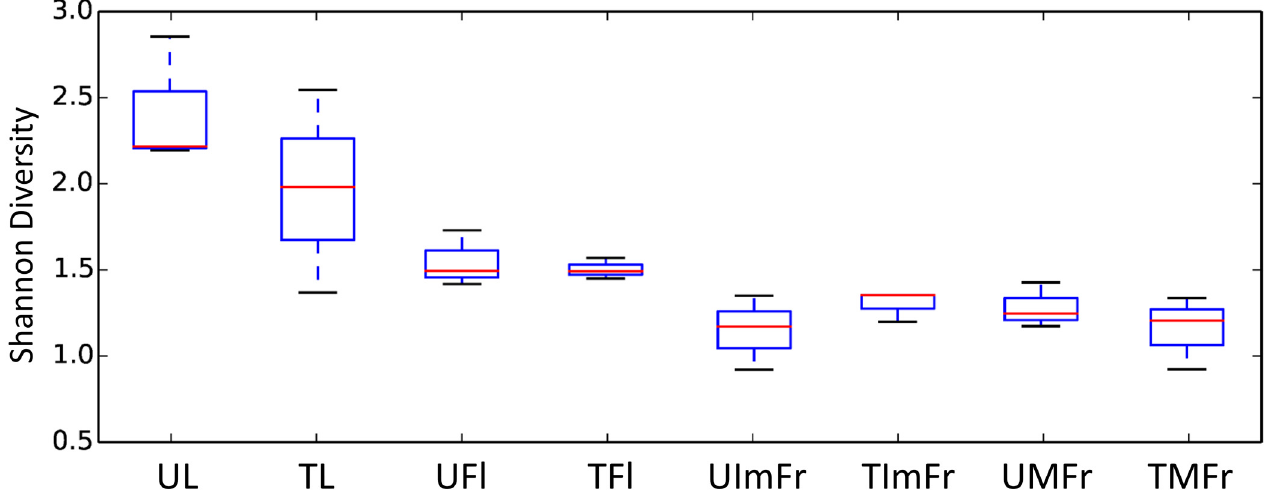
Fig 3. Boxplots visualizing results of the nonparametric two sample t-test to compare the alpha diversity of treated and untreated flowers (TFl and UFl), immature fruit (TIMFr and UIMFr), leaves (TL and UL), and mature fruit (TMFr and UMFr).